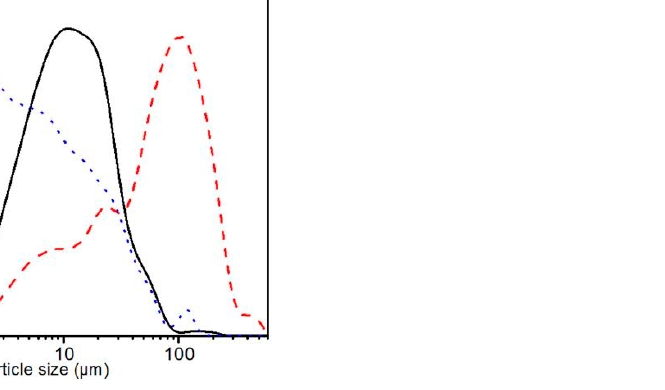
Figure 1. The particle size distribution of cement, fly ash and dolomite powder by the laser diffrac- tometry.